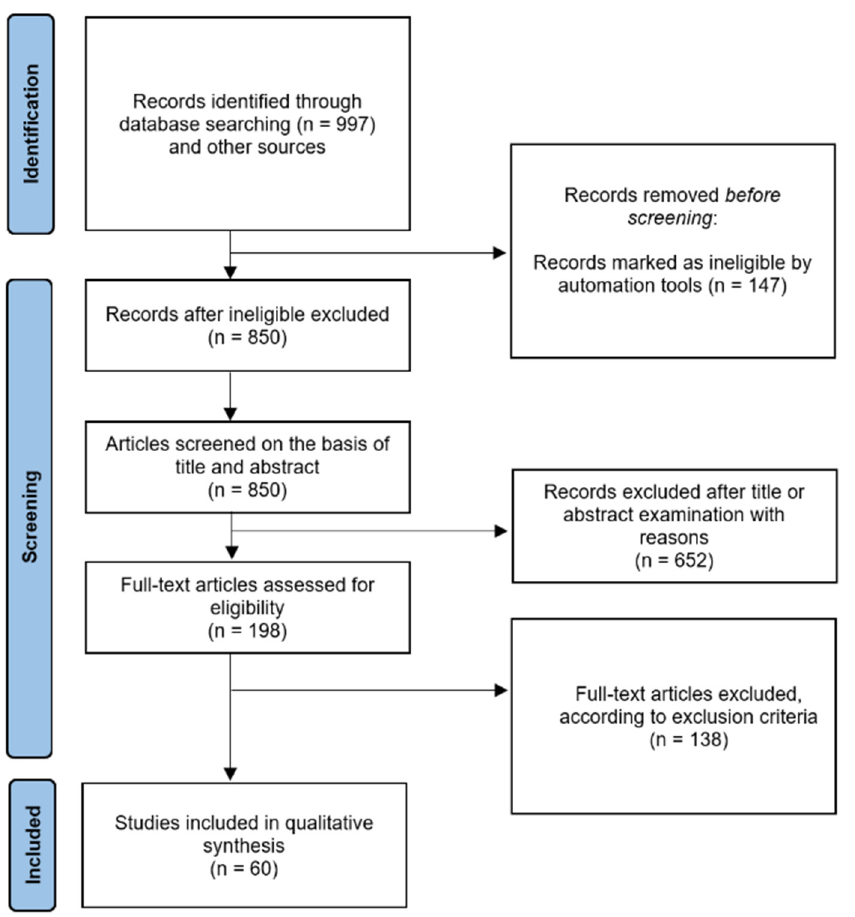
Figure 2. Preferred Reporting Items for Systemic Reviews and Meta-Analyses (PRISMA) 2020 flow diagram. A total of 60 studies were included in our systematic review.